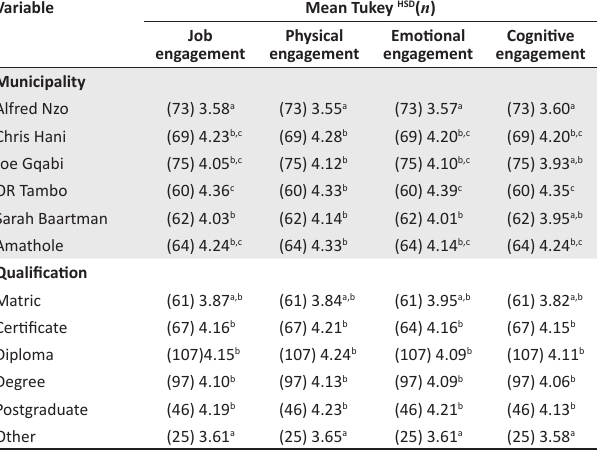
TABLE 3: Mean differences of job engagement and demographics.